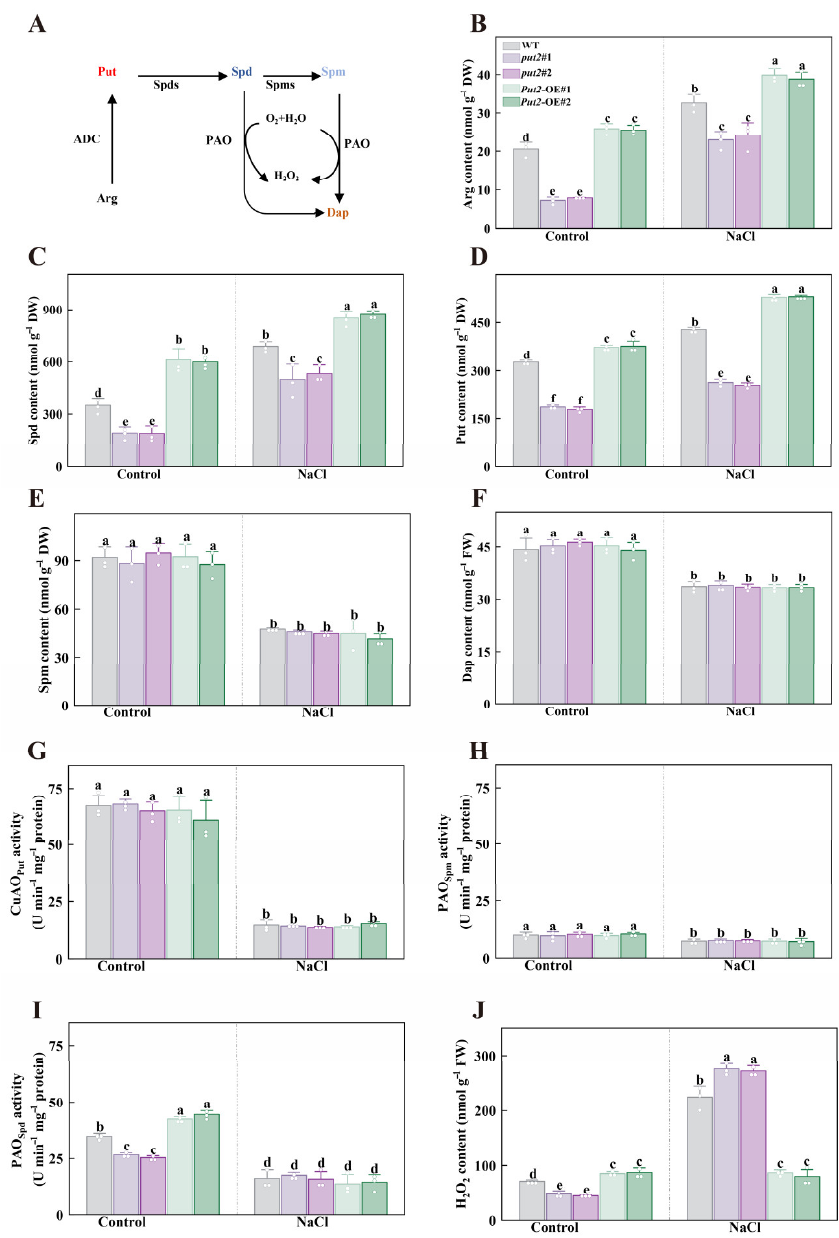
Figure 6. The role of Put2 in the regulation of polyamine metabolism and H 2 O 2 content. ( A ) Simpli- fied scheme of polyamine biosynthesis relevant to this study in plants; Arg, arginine, ADC, arginine decarboxylase, Put, putrescine, Spds, spermidine synthase, Spd, spermidine, Spms, spermine syn- thase, Spm, spermine, PAO, polyamine oxidase, Dap, 1,3-diaminopropane. ( B ) The Arg content in WT, put2 mutants, or Put2 OE lines with or without salt stress for 7 days. The content of the polyamines Spd ( C ), Put ( D ), Spm ( E ), and Dap ( F ) in WT, put2 mutants, or Put2 OE lines with or without salt stress for 7 days. The Put-dependent CuAO ( G ), Spd-dependent PAO ( H ), and Spm-dependent PAO ( I ) enzymatic activity in WT, put2 mutants, or Put2 OE lines with or without salt stress for 7 days. ( J ) The H 2 O 2 content in WT, put2 mutants, or Put2 OE lines with or without salt stress for 7 days. Data are presented as mean values ± SD; n = 3. Different letters indicate significant differences between treatments ( p < 0.05, Duncan’s multiple range test). At least three independent experiments were performed.